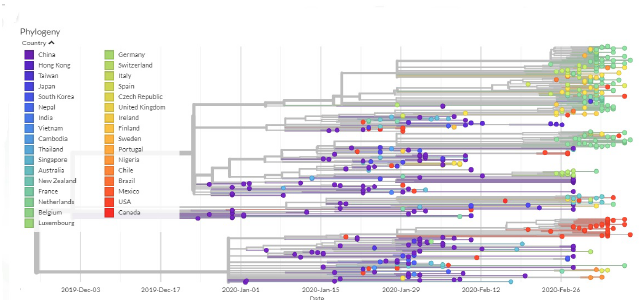
Figure A1. Phylogenetic tree from